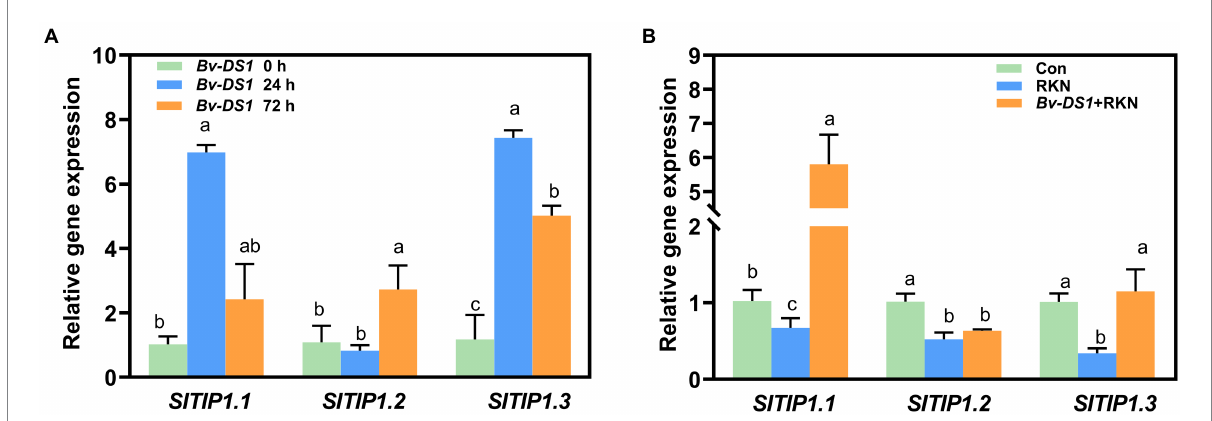
FIGURE 7 Bacillus velezensis YS-AT-DS1 ( Bv-DS1 ) activated the expression levels of SITIPs in tomato roots. (A) Expression levels of SITIPs in tomato roots after Bv - DS1 pre-inoculation for 0, 24, and 72 h. (B) Bv - DS1 treatments reversed the suppression of SITIPs in tomato roots induced by M. incognita at 3 dai. Relative gene expression level was normalised to the tomato reference gene SIEF . Each value is presented as mean ± SE of three biological replicates for three plant roots for each treatment. Different letters indicate significant differences between treatments ( p < 0.05) according to Tukey’s multiple comparisons test following one-way